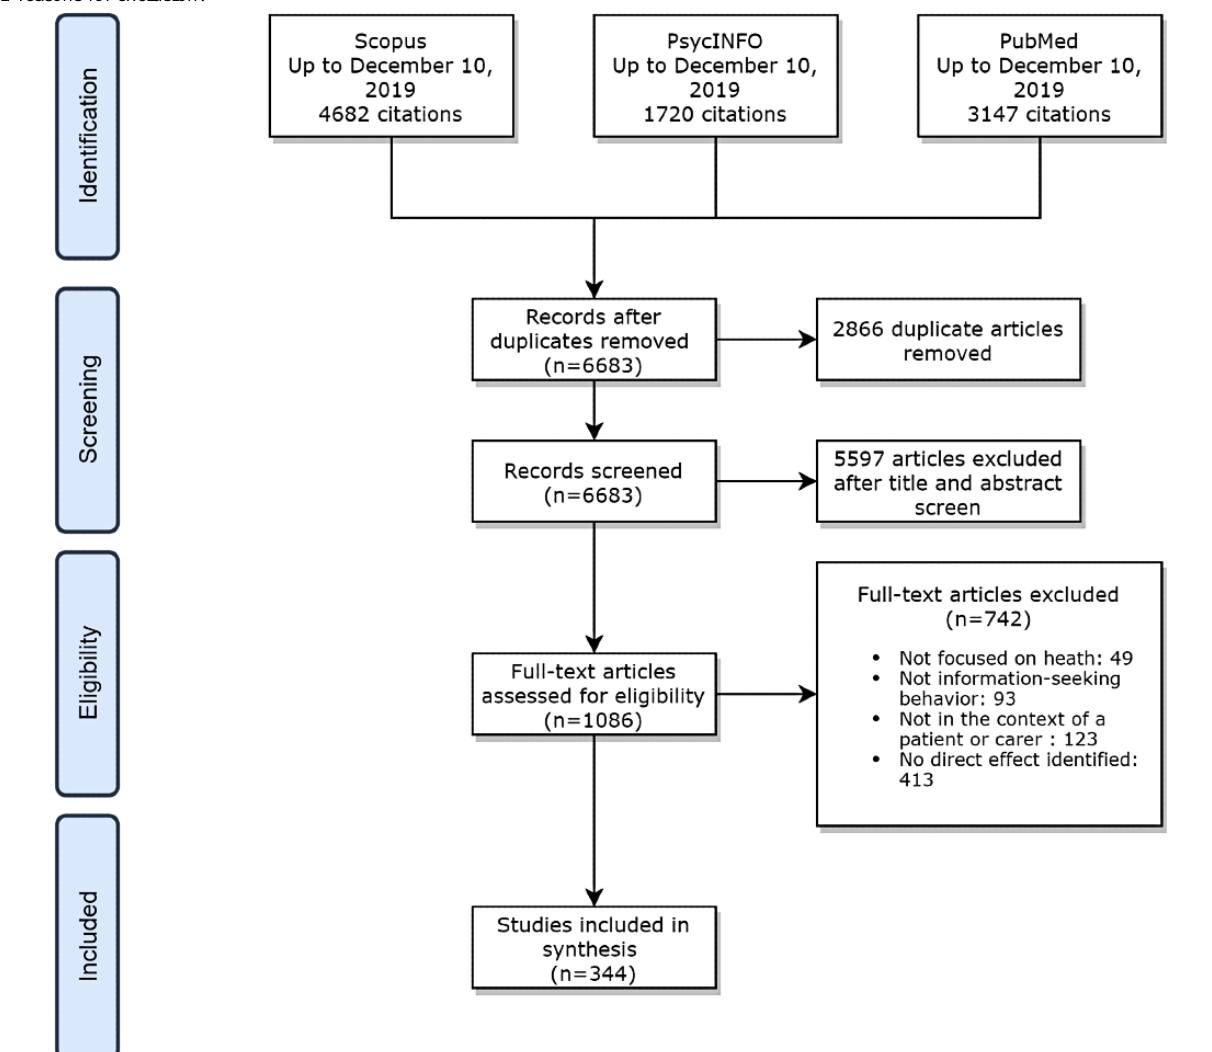
Figure 1. Flowchart for article inclusion. Reasons for exclusion do not sum to the number of excluded articles because some articles overlapped in their reasons for